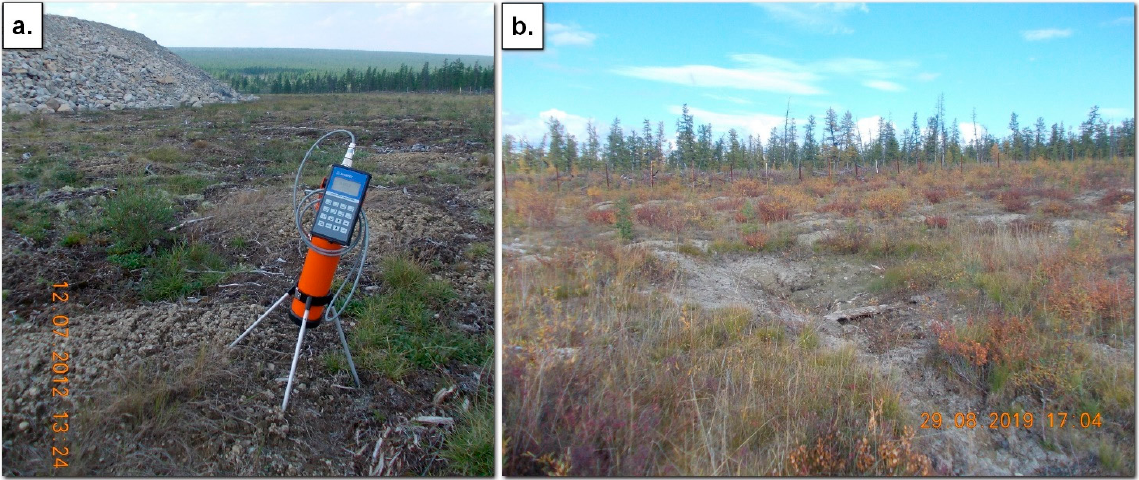
Figure 7. Patterned ground in the northeastern part of the Crystal site, in July 2012 ( a ) and in August 2019 ( b ). The pile of stones in the top left corner of the left panel is the artificial cover above the dome-shaped mound. Photograph by S. Artamonova.